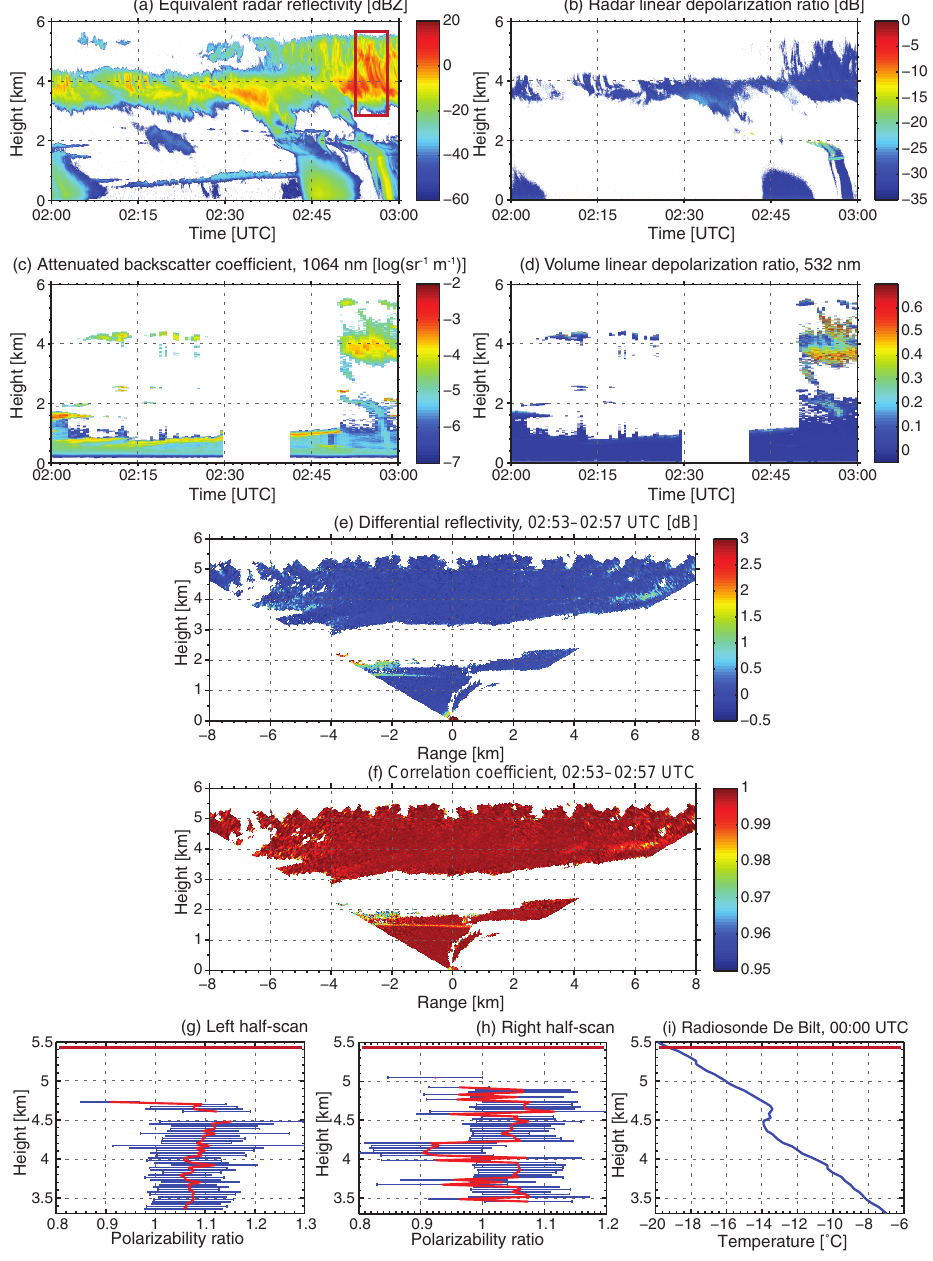
Figure 6. Same as in Fig. 3 but for 10 November 2014 and without a photograph.